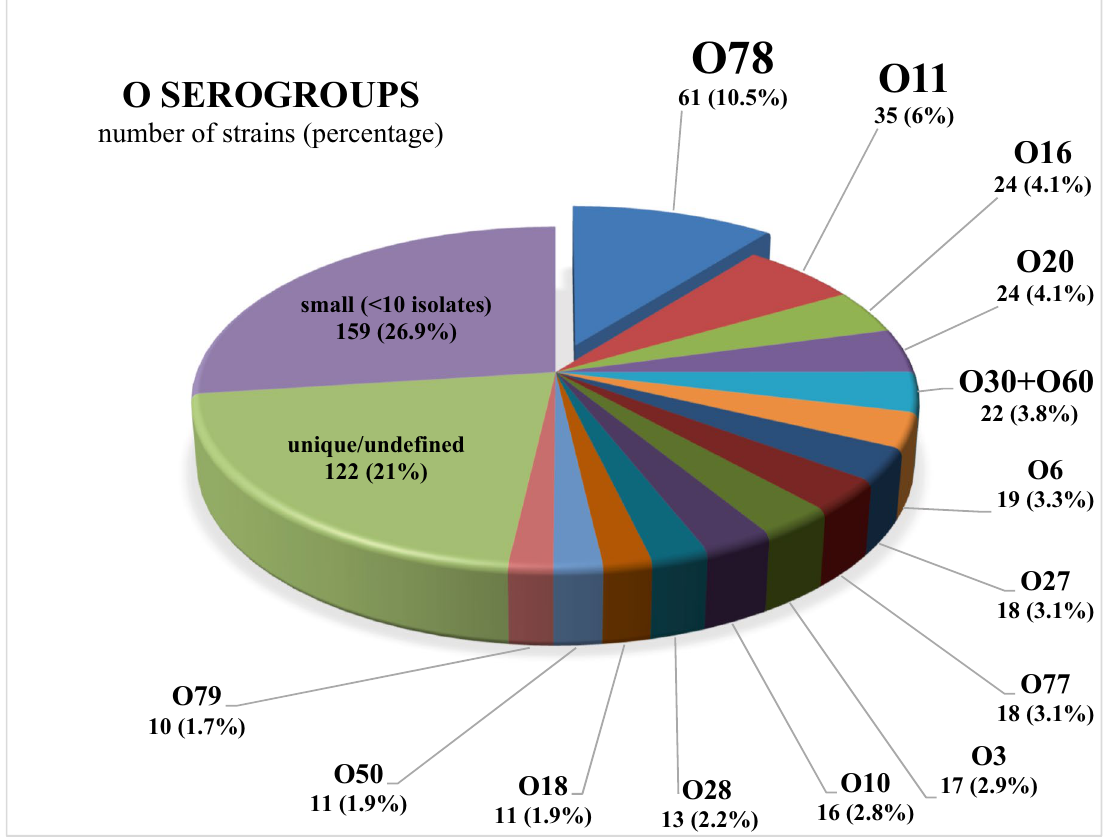
Figure 5. Classification of 580 S Proteus spp. strains into O serogroups [this work and 13–20